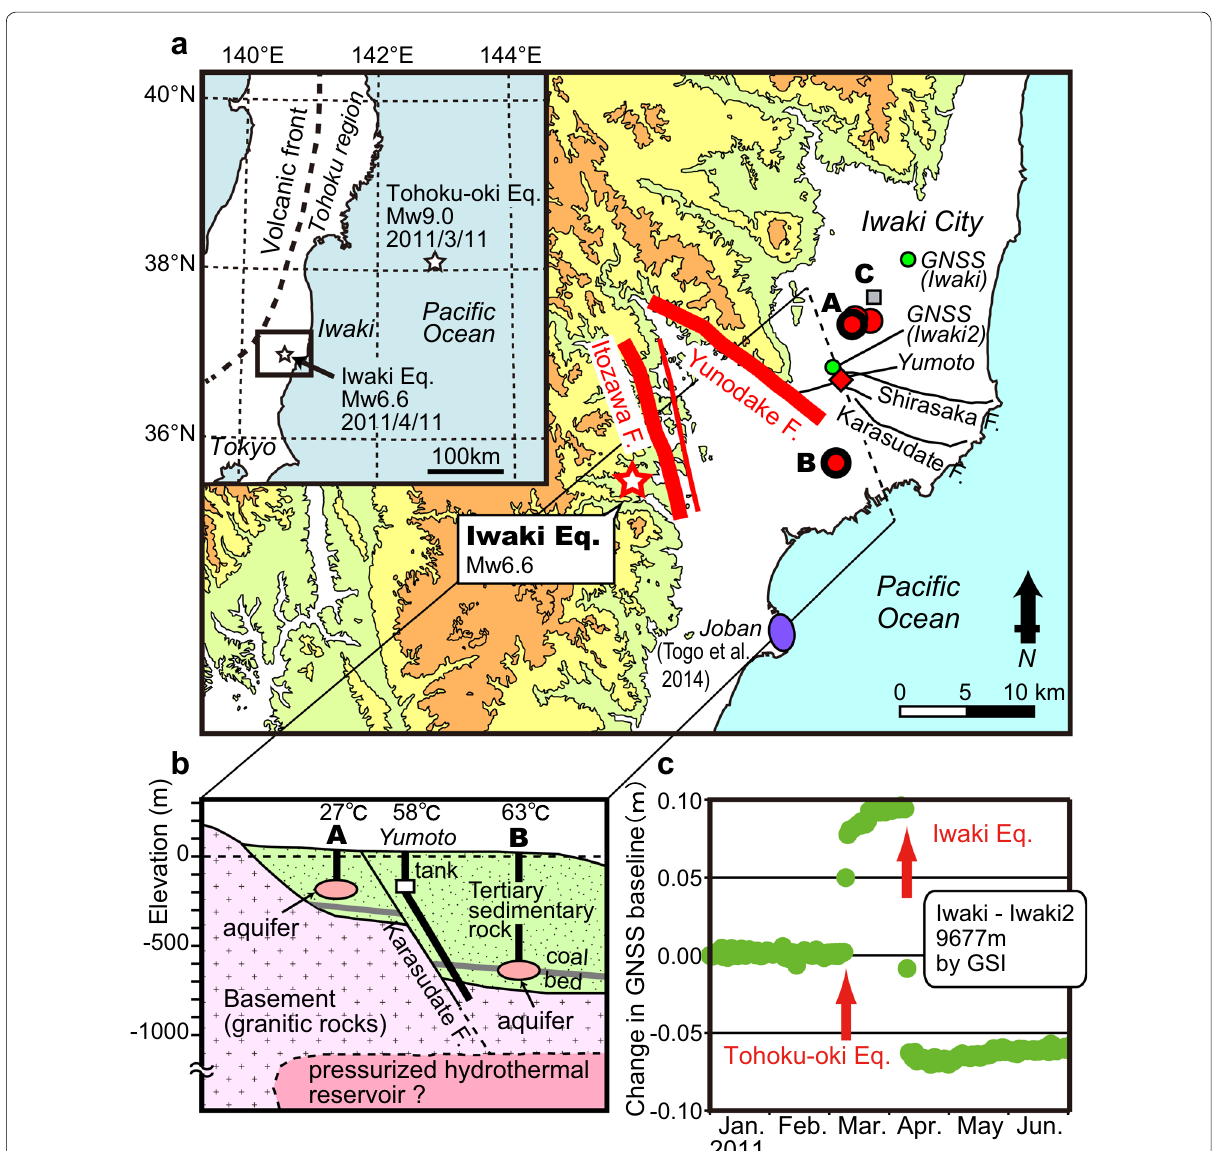
Fig. 1 Map of study location. a Hot spring water discharge after the 2011 Iwaki earthquake (red circles), where A and B denote sampling sites used in this study. Star and red lines show epicenter and faults that moved during earthquake, respectively. The fault names are after Mizoguchi et al. (2012). C denotes rain gauge operated by Japan Meteorological Agency (2019). Using geographical data from Geospatial Information Authority of Japan (2019), contour line interval is 200 m above sea level (light green areas: > 200 m; light yellow areas: > 400 m; orange areas > 600 m). Purple area indicates area labeled as “Joban” in Togo et al. (2014). b Schematic cross-section around hot springs at A, B, and Yumoto based on Sugai et al. (1957) and Ohara (1996). c Temporal changes in the Global Navigation Satellite System baseline between Iwaki and Iwaki2 (indicated by green circles in a ) from Geospatial Information Authority of Japan